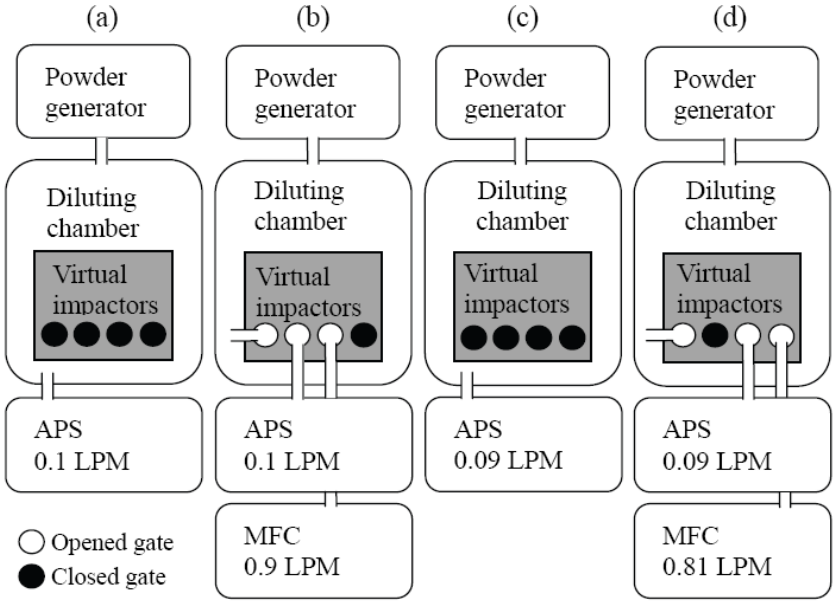
Figure 7. Schematics of the particle collection efficiency experiment of the two virtual impactors. The particle size distribution at each step is measured with an aerodynamic particle